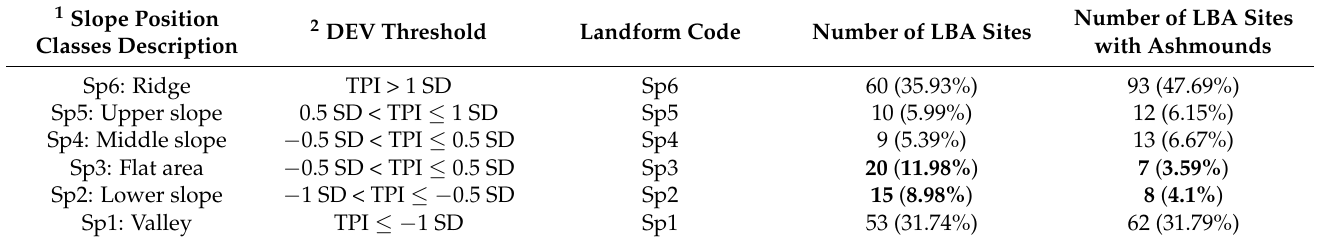
Table 6. Descriptive statistics of LBA sites (see Figure 7a) vs. LBA sites with ashmounds (see Figure 7b) occurring over six slope position classes in the Jijia